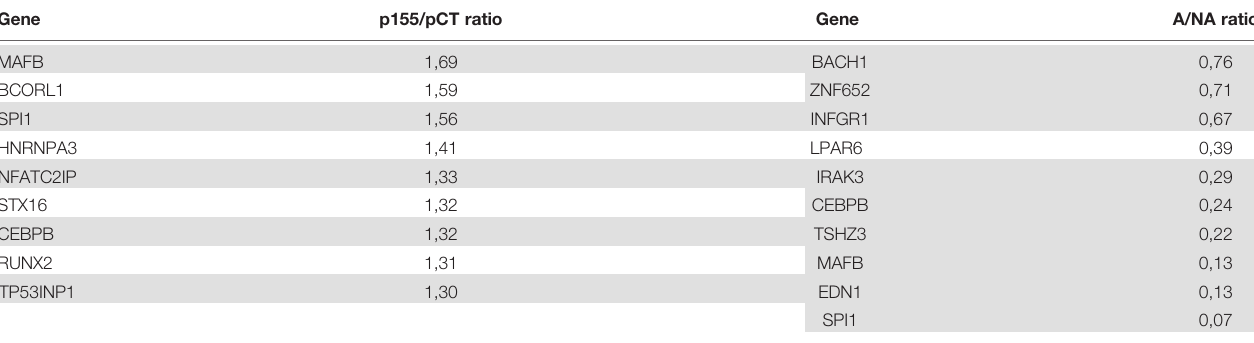
TABLE 2 | Short list of target genes modulated in PBMCs after coculture with premiR-155 overexpressing MSCs or PHA activation. Gene p155/pCT ratio Gene A/NA